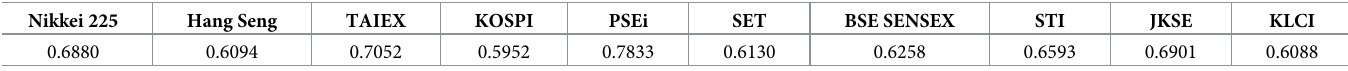
Table 5. Mean sample entropy for data series of length 180 used in calculation of A and κ .